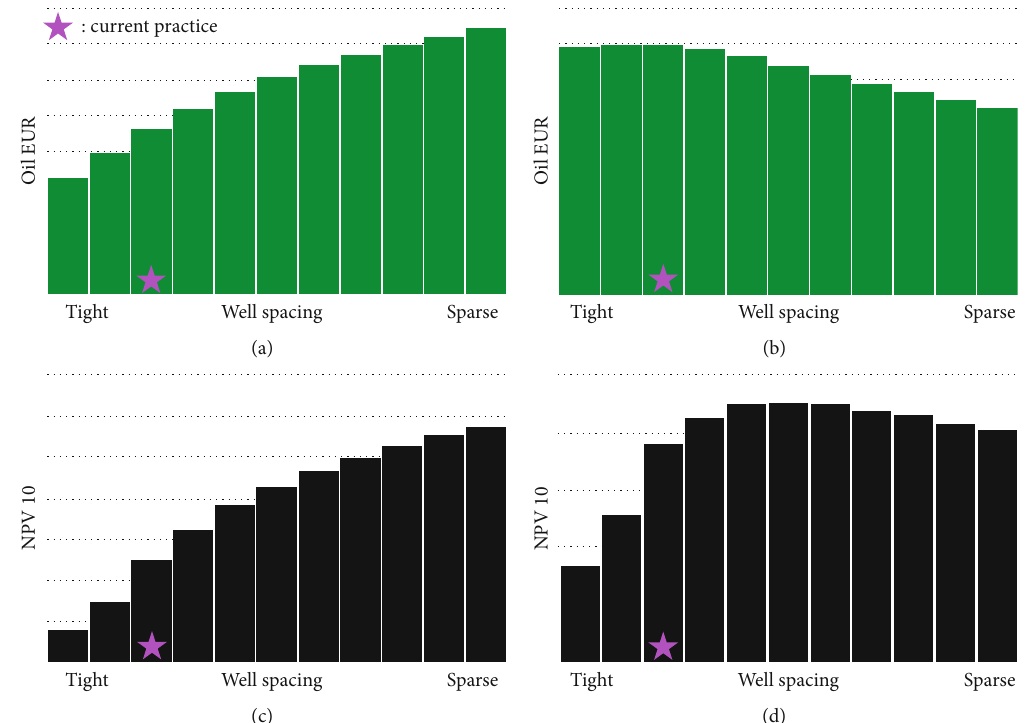
Figure 17: Lateral well spacing sensitivity results: (a) EUR per well pad, (b) EUR per one section, (c) NPV10 per well pad, and (d) NPV10 per one section.